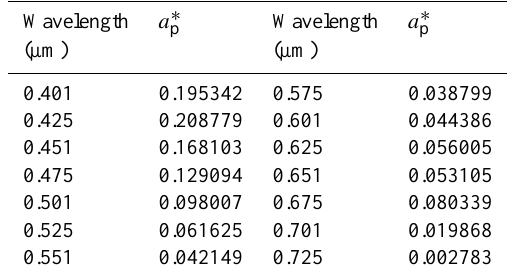
Table 5. New spectral absorption coefficients of water particles de- rived from the in situ data, which are used only when the concen- tration of [Chl] sur is greater than 15mgm − 3 , for the calculation of the particulate absorption.